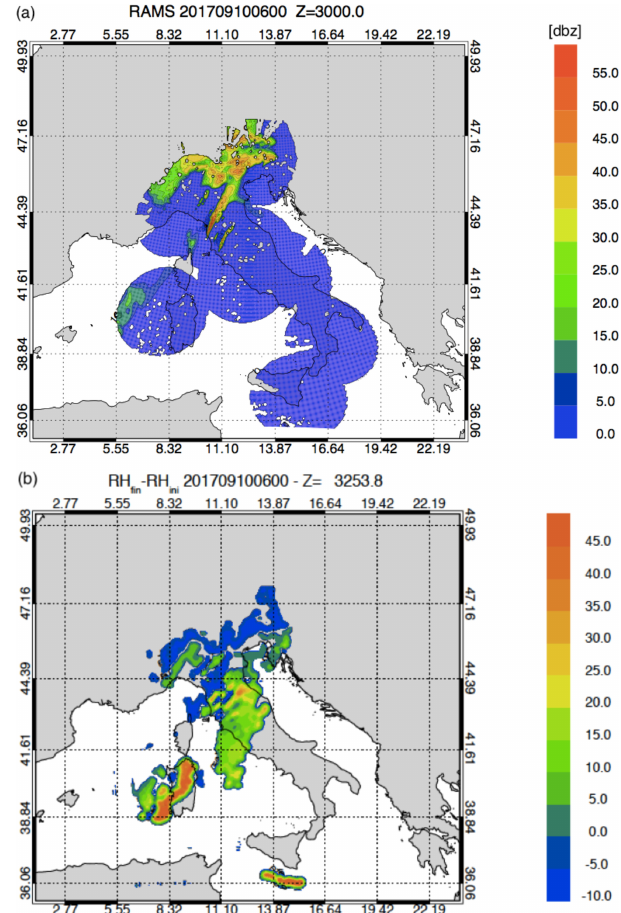
Figure 14. (a) RAMS@ISAC reflectivity factor simulated 3km above sea level at 06:00UTC on 10 September 2017; (b) relative humidity difference between the analysis and the background at 06:00UTC at the 3.2km level in the terrain following the vertical coordinate of